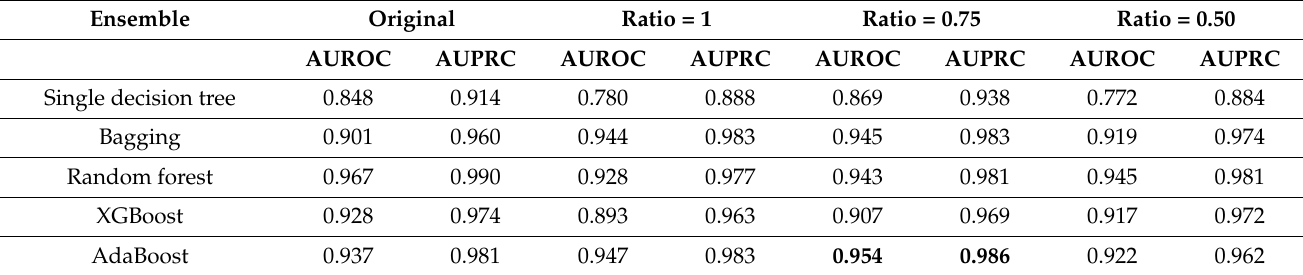
Table 6. The performance metric of ensembles (standard decision tree) along with the undersampling method (RUS) of minority and majority class points for different ratios. (Bold numbers show the best results.) AUROC and AUPRC performance metrics are considered for this experiment.